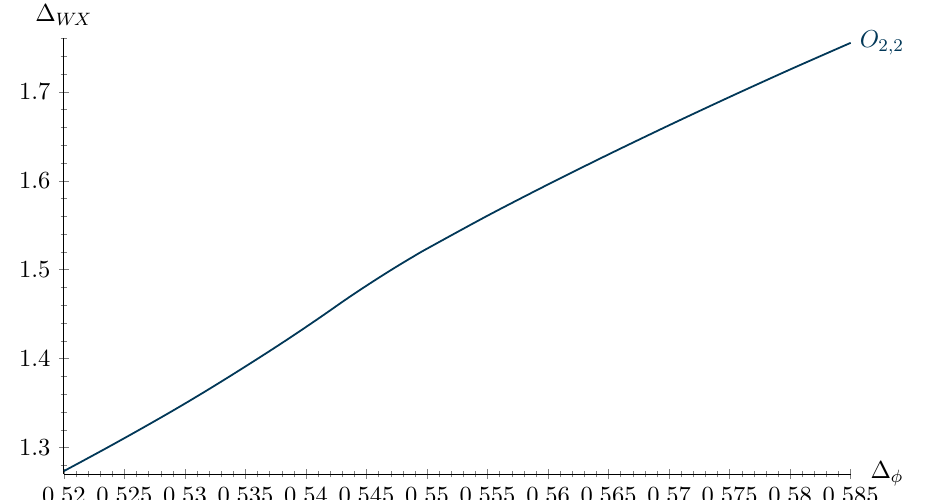
Figure 15: Upper bound on the dimension of the first scalar WX operator in the φ × φ OPE as a function of the dimension of φ . The area above the curve is ar bs